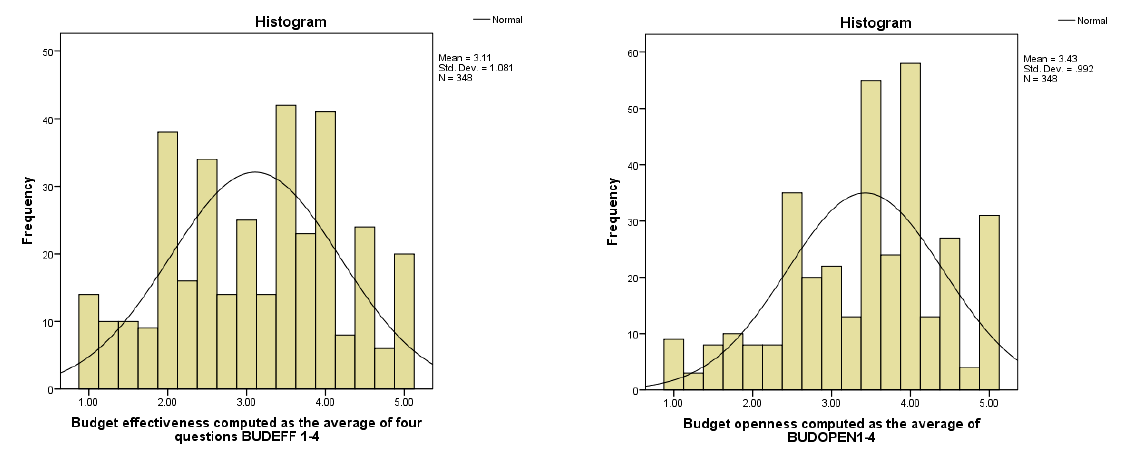
Figure 1. Normality distribution for BUDEFF Figure 2. Normality distribution for BUDOPEN